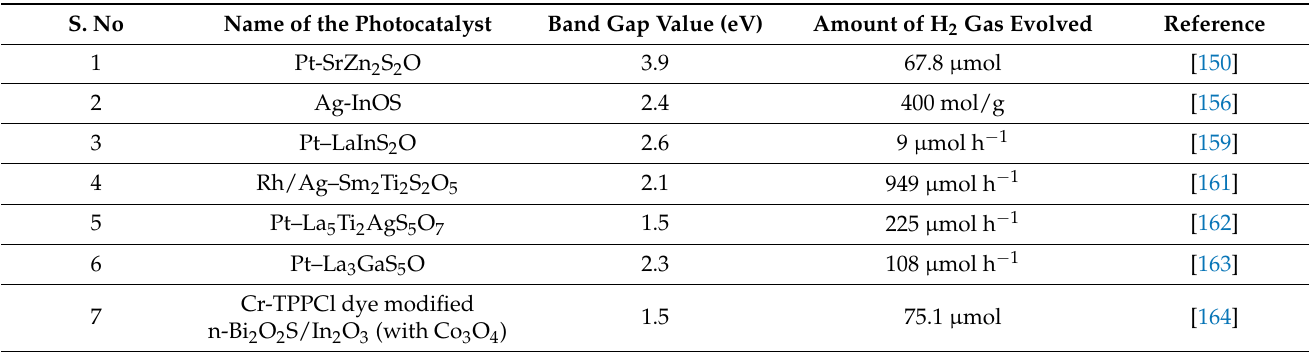
Table 3. List of oxysulphide-based photocatalysts with their band gaps and H 2 evolution in differ- ent